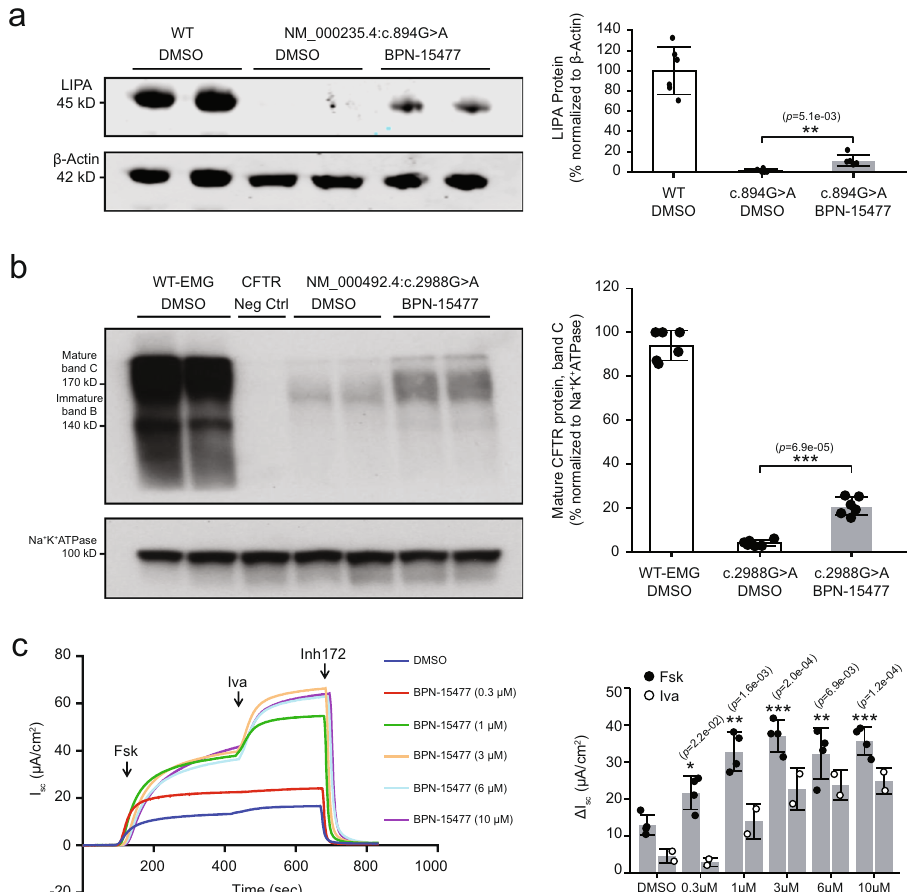
Fig. 5 BPN-15477 treatment increases LIPA and CFTR protein in disease-relevant cellular models. a Western blot analysis of LIPA protein in patient fi broblasts carrying the c.894G> A mutation. Left: Top and bottom panels show the blot probed with anti-LIPA and anti-ß-Actin antibody, respectively. Right: Bar chart showing the densitometric analysis of the western blot expressed as percentage of WT. LIPA was normalized to ß-Actin. To generate the bar plot, the experiment was independently repeated six times ( n = 6). b Western blot analysis of CFTR protein in 293-Flpin cells stably expressing WT- EMG-i14-i18 or c.2988G > A-EMG-i14-i18. 293-Flpin cells with no endogenous expression of CFTR protein served as negative control. Left: Top and bottom panels show the blot probed with anti-CFTR and anti-Na + K + ATPase antibody, respectively. Right: Bar plot showing the densitometric analysis of the western blot expressed as percentage of mature CFTR protein, band C. Amount of mature CFTR protein was normalized to Na + K + ATPase. To generate the bar plot, the experiment was independently repeated six times ( n = 6). In ( a ) and ( b ), data are presented as mean values ±S.D. The statistical signi fi cance is determined via two-tailed Welch ’ s t -test. The unadjusted p values are displayed. c CFTR chloride channel analysis in CFBE-Flpin cells stably expressing c.2988G > A-EMG-i14-i18. Left: A representative tracing of short-circuit current ( I sc ) measurements recorded in Ussing chambers after treatment of cells with either DMSO (vehicle) or variable doses of BPN-15477 for 72 h, as indicated on the fi gure labels. Cells were mounted on Ussing chambers to measure CFTR mediated chloride channel. After stabilization of the basal current, forskolin (10 μ M) was added to the basolateral chambers followed by CFTR potentiator, Ivacaftor (10 μ M), and CFTR Inhibitor 172 (10 μ M) added to the apical chambers. Right: the bar plot indicates recovery of CFTR function upon treatment of cells with BPN - 15477. Change in I sc ( Δ I sc ), a measure of CFTR function, was de fi ned as the current inhibited by Inh-172 after sustained I sc responses were achieved upon stimulation with forskolin (Fsk, n = 4 I sc measurements per treatment) alone or sequentially with ivacaftor (Iva, n = 2 I sc measurements per treatment). Data are presented as mean values ± SD. The statistical signi fi cance is determined via two-tailed Welch ’ s t -test when forskolin-stimulated CFTR function was compared between BPN-15477 treated and DMSO (vehicle) treated cells. The unadjusted p values are displayed. In the fi gure, * p < 0.05; ** p < 0.01; *** p <